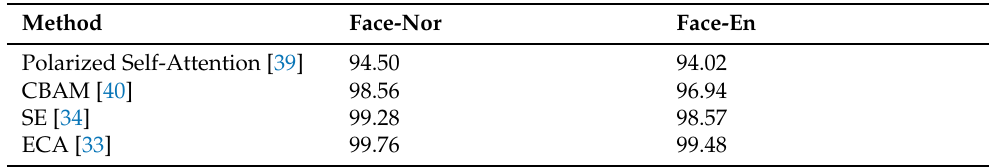
Table 3. Face verification comparison (%) on Face-Nor and Face-En when using different atten- tion mechanisms.